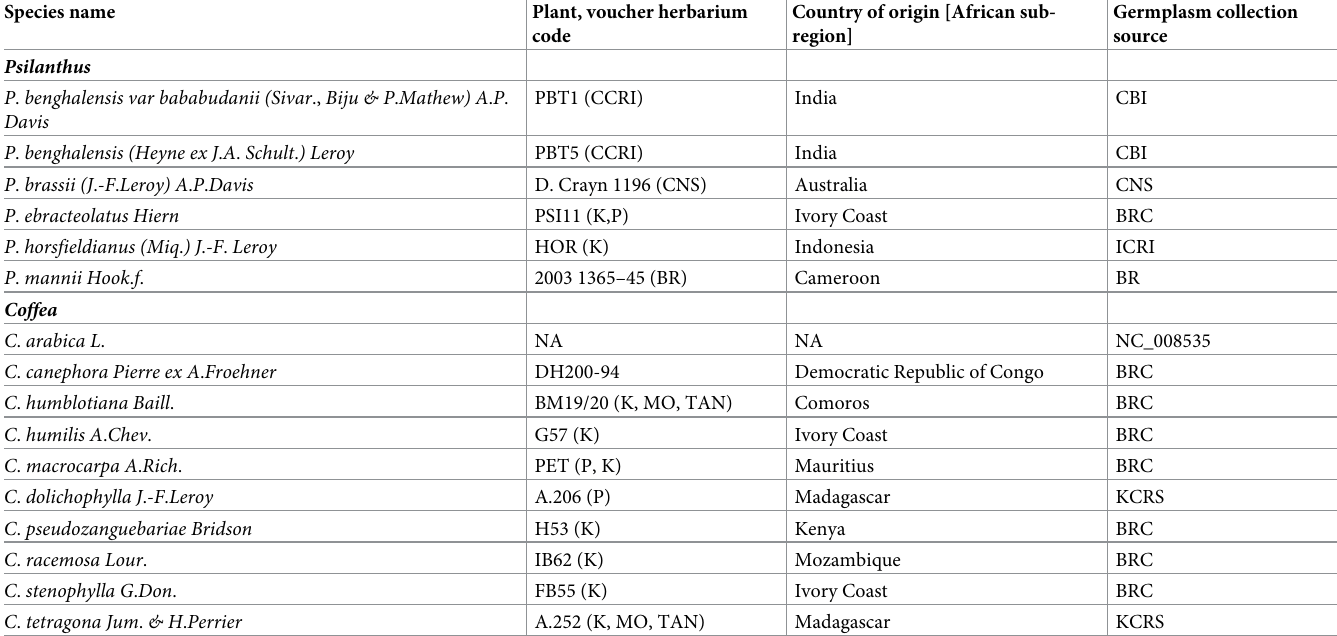
Table 1. Species considered in this study for chloroplast genomes analyses. Herbarium codes after Holmgren et al. (1990). Germplasm source BR (Botanic Gardens of Belgium), BRC (Biological Resources Center, Reunion), CBI (Coffee Board of India), K (Royal Botanic Gardens, Kew (UK), KCRS (Kianjavato Coffee Research Station (Madagascar), P (Natural History Museum, Paris